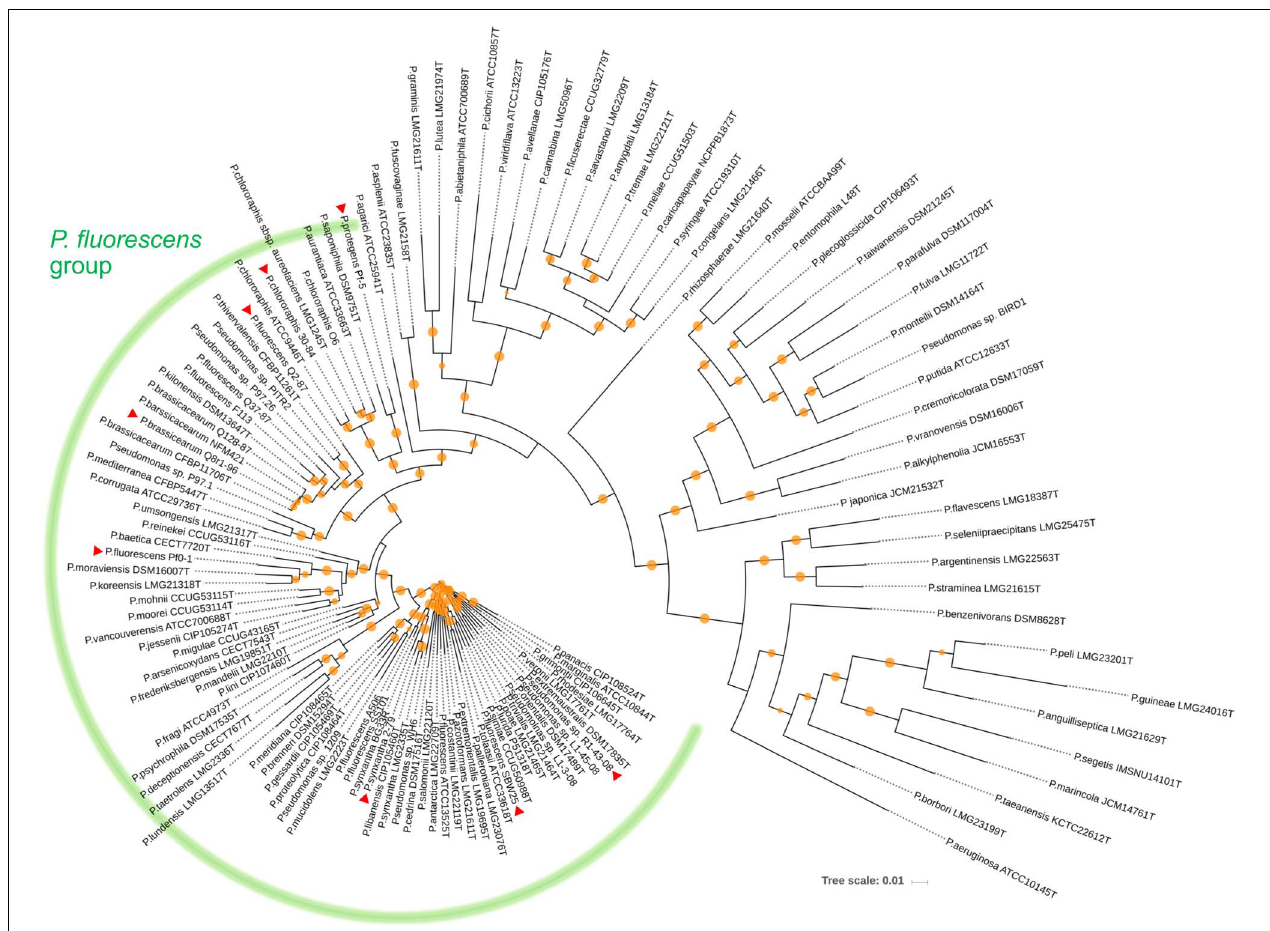
FIGURE 1 | Neighbor joining phylogeny showing the relationship of the eight strains used in this study (indicated by red triangles) to different species of the P. fluorescens complex. The phylogeny was established based on the concatenated sequences of the housekeeping genes rrs (16S rRNA), gyrB (subunit B of DNA gyrase), rpoB ( β subunit of RNA polymerase), and rpoD (sigma 70 factor subunit of RNA polymerase). Distance matrices were calculated by the Jukes-Cantor method. Colored circles on tree nodes indicate bootstrap values (1,000 replicates) that vary between 60% (smallest circle) and 100% (largest